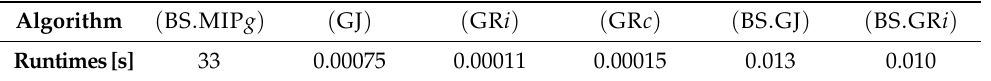
Table 2. Average running times to compute the Pareto frontiers over 100 instances, in